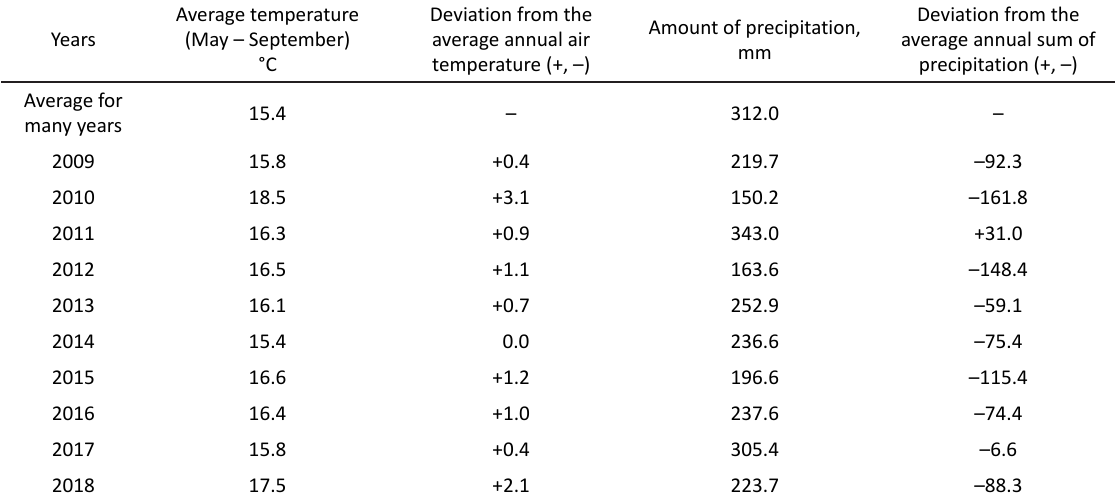
Deviation from the Amount of precipitation, average annual sum of mm precipitation (+, –)